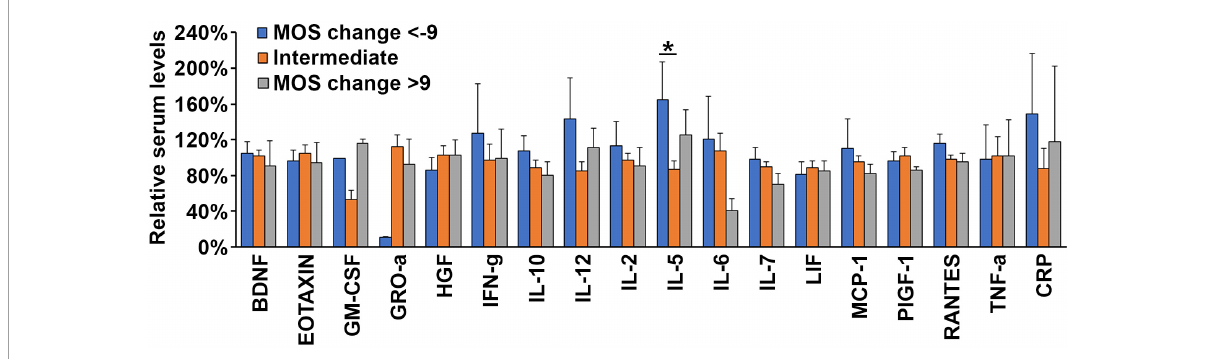
FIGURE7 High serum levels of IL5 is associated with sleep improvement during oncological therapy. Average levels of normalized plasma concentrations of each of the 17 biomarkers selected for this study and CRP within groups of patients exhibiting a large gain in sleep quality (MOS change < -9, blue bars), an intermediate gain or loss of sleep quality (MOS change < ± 9, orange bars) and a large loss of sleep quality (MOS change > 9, gray bars) after a round of oncological therapy. N = 71. * p <